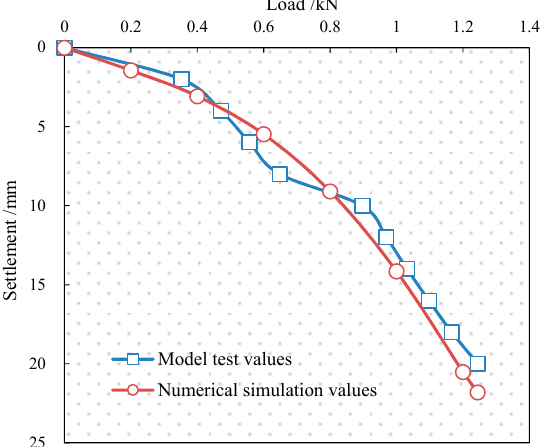
Figure 16. Relationship between load and settlement of pile top in numerical simulation and model test.